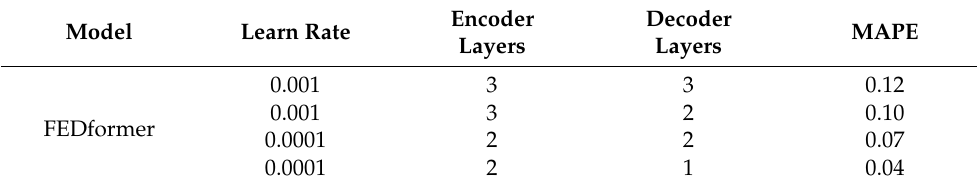
Table 3. Parameter setting for the FEDformer